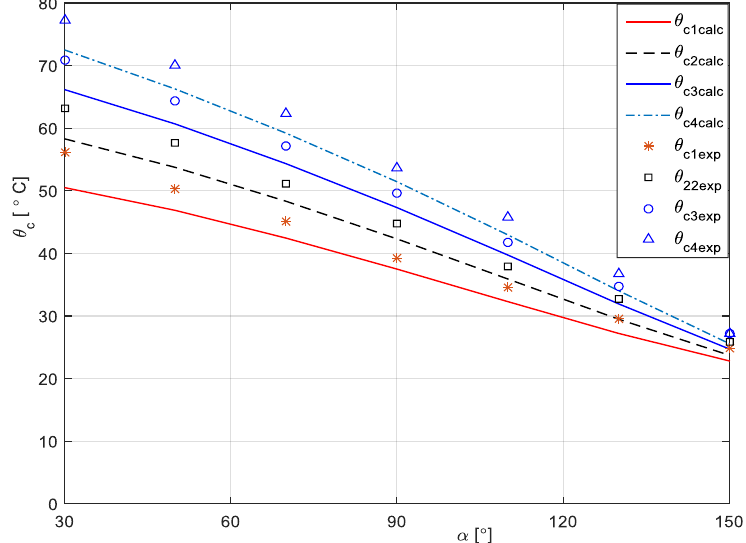
Figure 12. Case temperature variation vs. firing angle at different current values of 200, 250, 300, and 340 A ( v air = 3 m/s; R = 3 Ω; L = 30 mH).